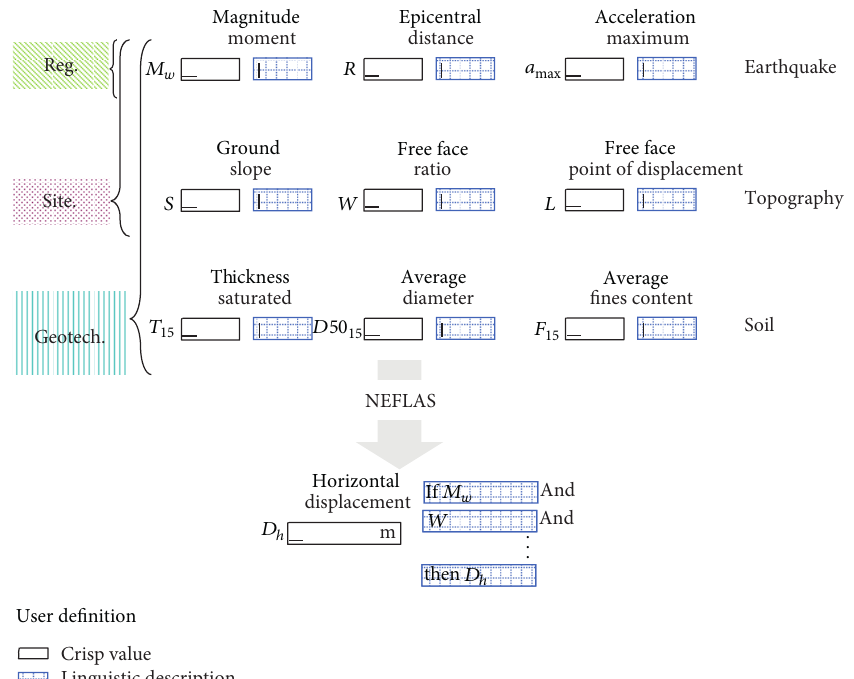
Figure 32: Neurofuzzy structure (NEFLAS is for neurofuzzy system to estimate lateral spread displacement).